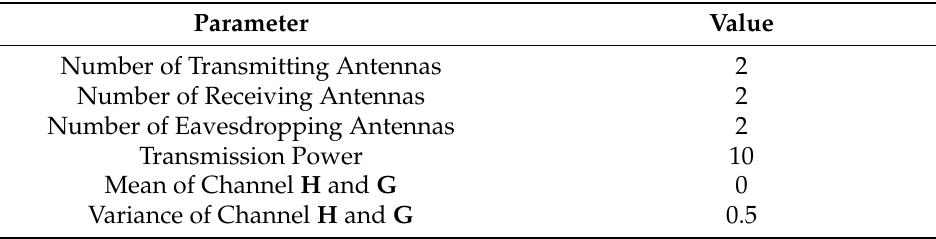
Table 6. Simulation Parameters for